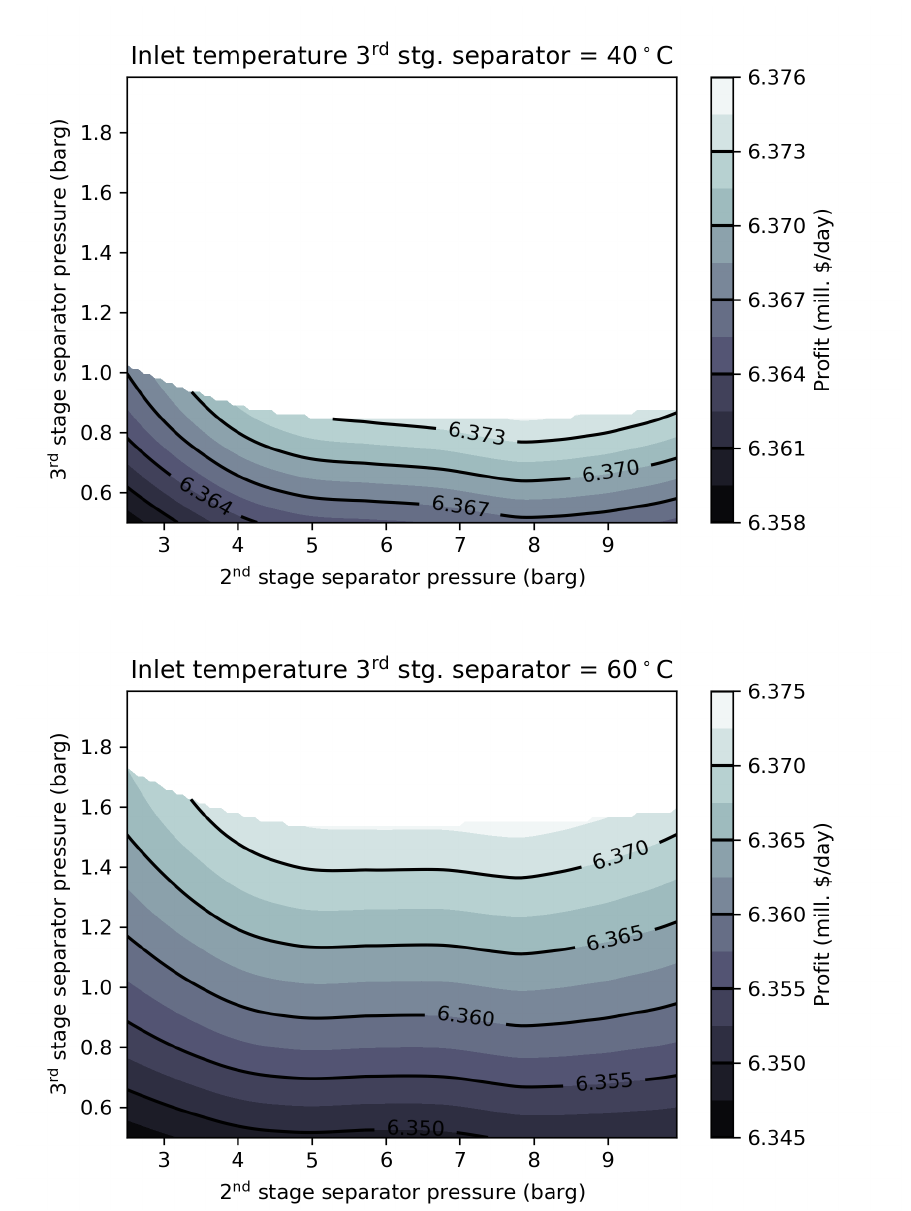
Figure 6. Profitfunction as a function of 2nd and 3rd stage separator pressure using the surrogate model. Objective function calculated with 52 ◦ C and 32 barg in the 1st stage separator, 25 ◦ C in all compressor suction scrubbers, 60 barg after the HP compressor, and − 5 ◦ C in the refrigeration/dew point control unit. The profit function has been masked for Reid Vapor Pressure (RVP) > 12 psia. The upper figure is obtained with a 3rd stage separator temperature of 40 ◦ C, and the lower figure with 60 ◦